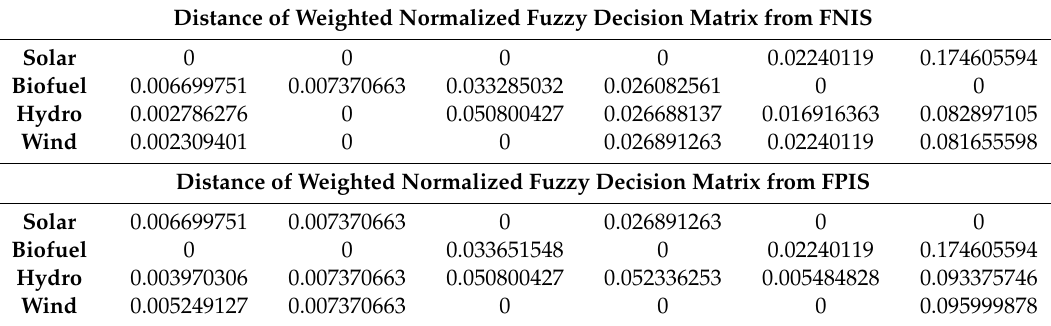
Table 12. Calculation of the distance from FNIS and FPIS.